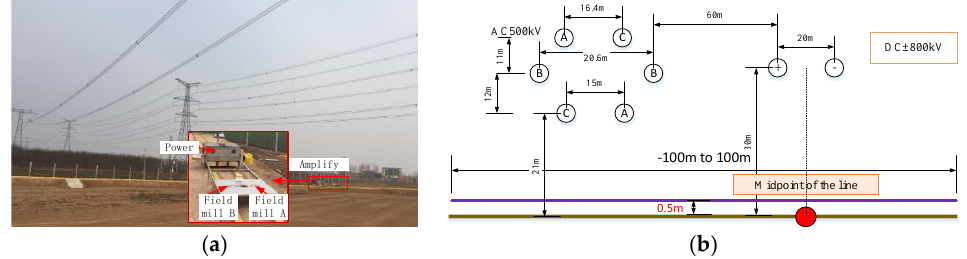
Figure 6. Experiment and transmission lines parameters. ( a ) Experiment setting. ( b ) The parameters of the transmission lines.